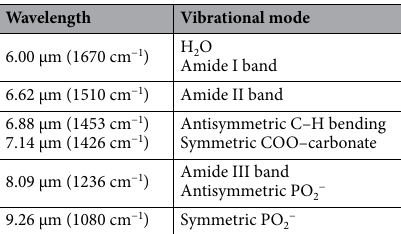
Table 1. Absorption peaks in the FT-IR spectrum and their vibrational assignments.